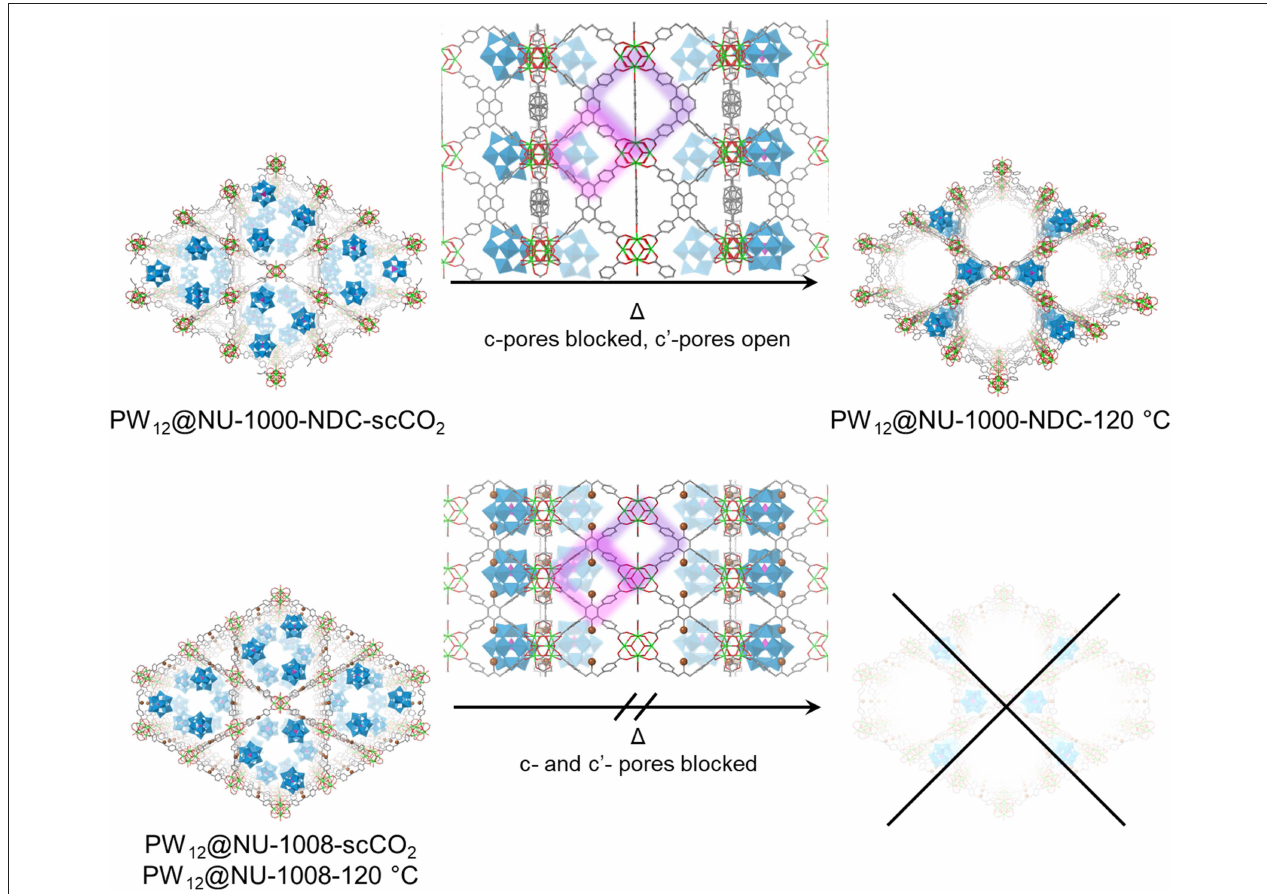
FIGURE 5 | Proposed structures and transitions for PW 12 @NU-1000-NDC (top) and PW 12 @NU-1008 (bottom) under heating conditions. The c- and c ′ - pores are highlighted in purple and pink, respectively. For clarity, hydrogens are omitted. Green polyhedron = Zr 6 node, blue polyhedron = WO 5 , pink polyhedron = PO 4 , green sphere = Zr, red = O, gray = C, brown = Br.